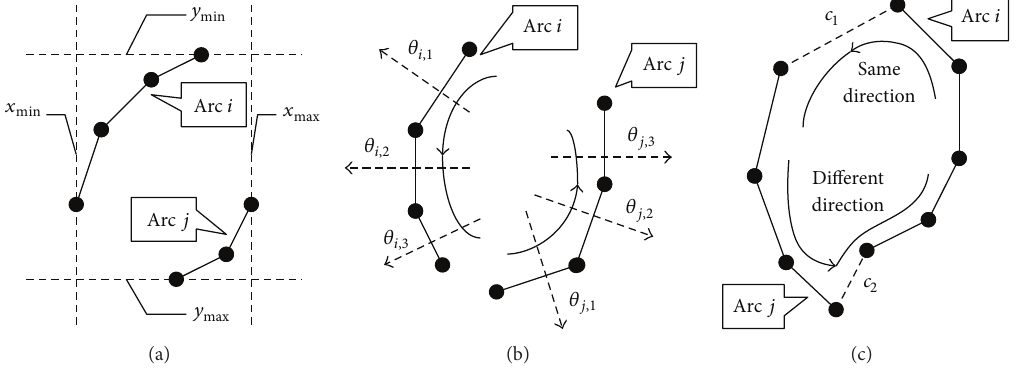
Figure 7: Illustrations of elliptical arc merging conditions. (a) The condition of distance. (b) The condition of coinciding degree, which is 0 for arc 𝑖 and arc 𝑗 . (c) The condition of rotating direction; chord c 2 makes the rotating direction of the whole curve not consistent.